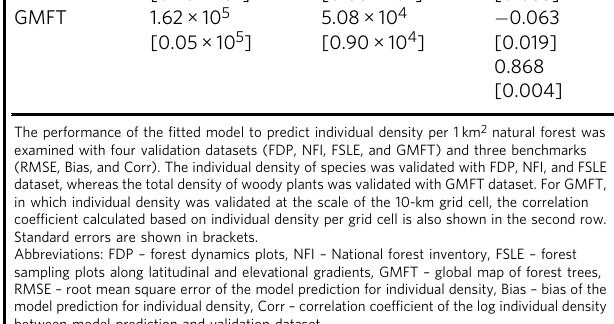
Table 1 Predictive performance of the fi tted model. Dataset